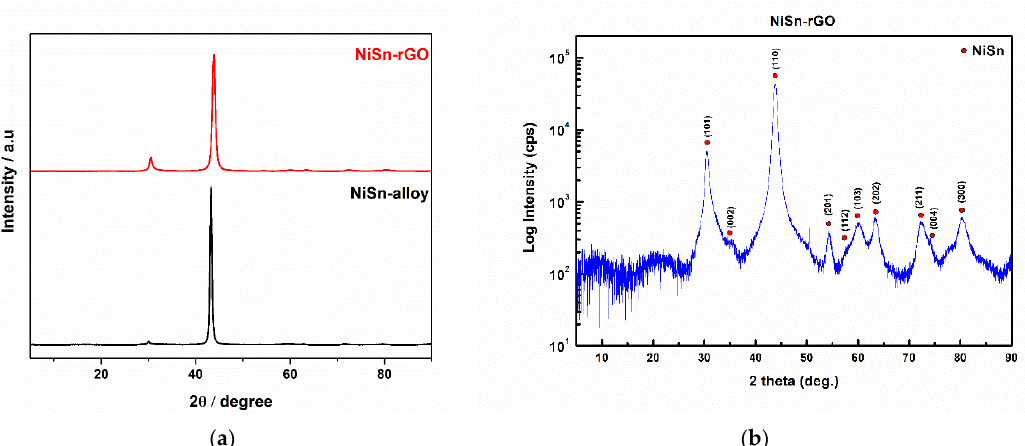
Figure 12. X-ray diffraction patterns of electrodeposited NiSn-P3.3 alloy and NiSn-rGO-P3.3 Figure 12. X-ray di ff raction patterns of electrodeposited NiSn-P3.3 alloy and NiSn-rGO-P3.3 composite composite on copper substrate: ( a ) linear scale and ( b ) logarithmic scale. on copper substrate: ( a ) linear scale and ( b ) logarithmic scale.